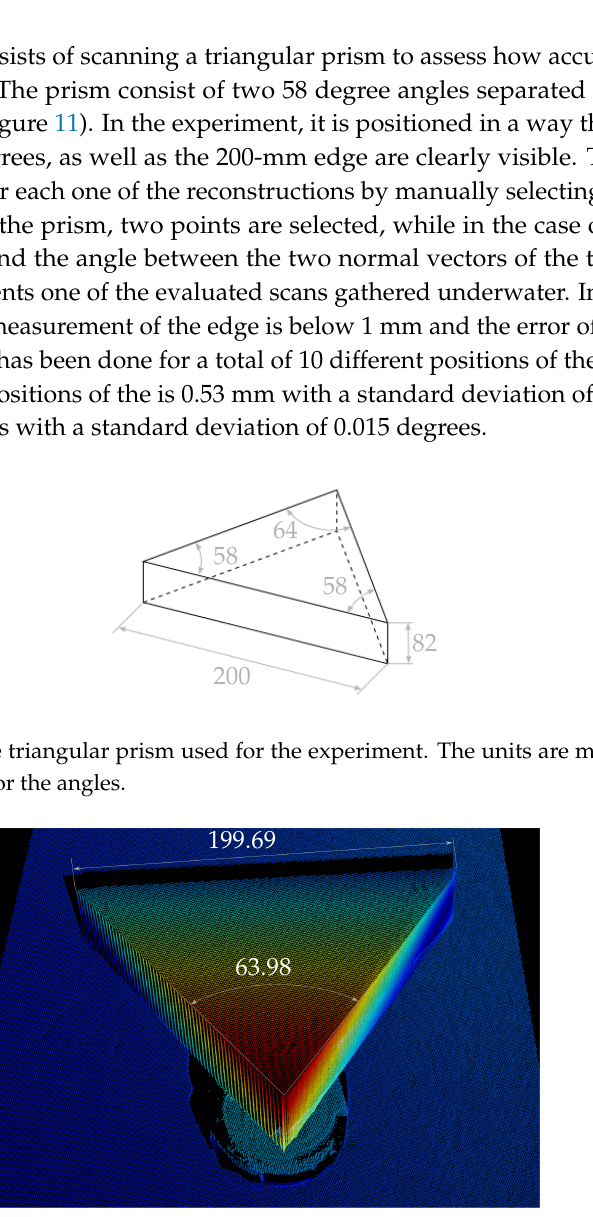
Figure 12. Partial view of a reconstructed area. The cloud has been coloured according to each point’s distance to the background for easier interpretation. The units are millimetres for the distance and degrees for the